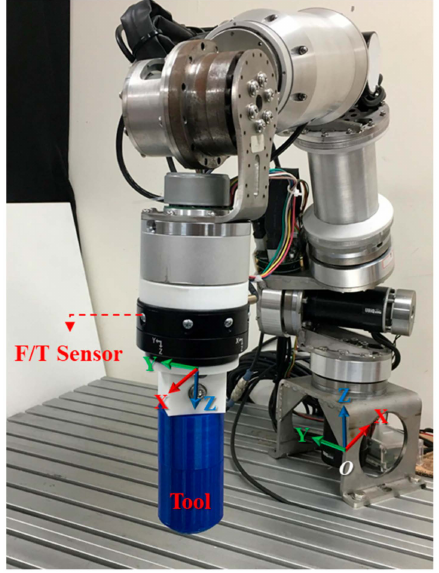
Figure 6. Coordinate system on Force / Torque